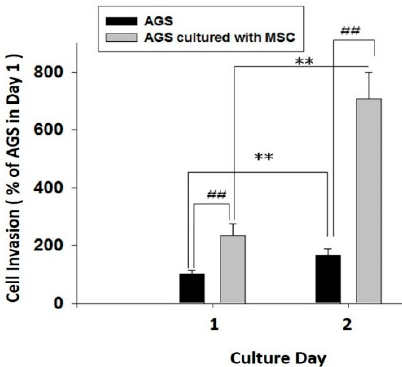
Figure 8. HBMMSCs enhances invasive motility in human gastric cancer cells. HBMMSCs and human AGS gastric cancer cells were cultured for 24 and 48 h, respectively. The effect of HBMMSCs on cellular motility of human gastric cancer cells were measured. The responses to HBMMSCs were measured by invasive motility assay. ** p < 0.01, only AGS cells in day 2 versus only AGS cells in day 1; ## p < 0.01, AGS cells cultured with MSC versus only AGS cells (mean ± SD, n = 3). Human AGS gastric cancer cells were placed in the upper chamber pre-coated with collagen I; and lower compartment was seeded with HBMMSCs in the co-culture system. The co-culture system was filled with serum- and phenol red-free medium and incubated for 24 and 48 h, respectively. We